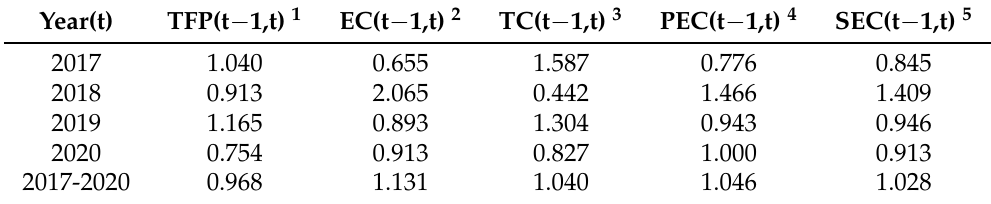
Table 5. Annual geometric means of the Malmquist index of PHCI in Shenzhen from 2017 to 2020.